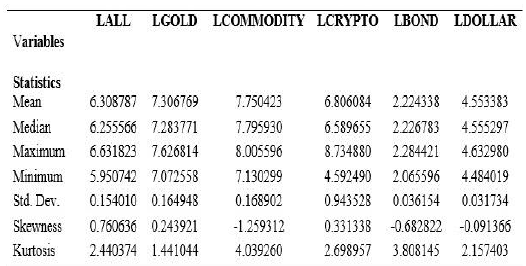
Table 2: Descriptive Statistics